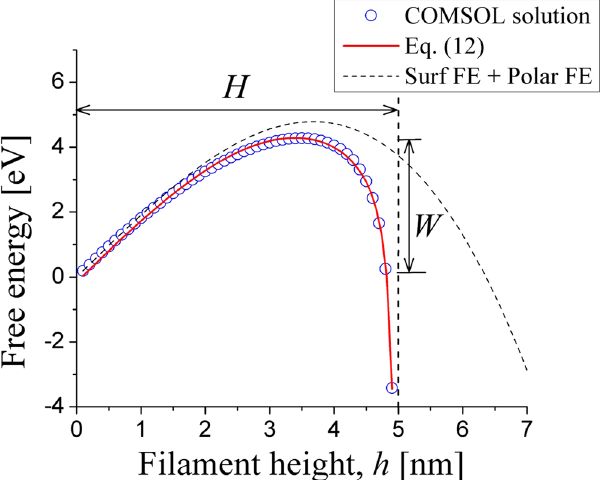
Figure 3. The free energy of CF in a narrow gap between two electrodes. Symbols represent the results of the COMSOL numerical modeling for 0.5 nm radius CF between the two coaxial circular metal electrodes of 10 nm radius each. The solid line is a fit by Eq. (12). The dashed line is the free energy corresponding to the same surface tension and polarization, but without the capacitive